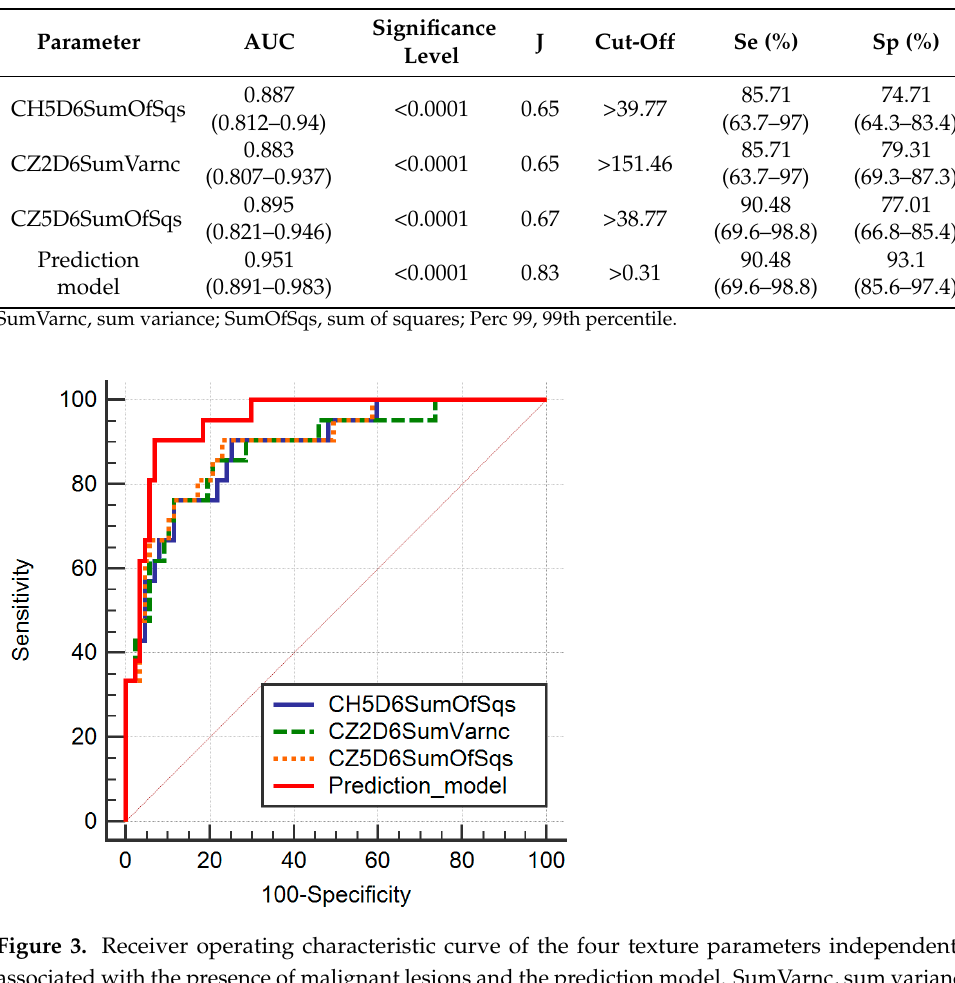
Table 4. The k-nearest neighbor classifier’s results. The values between the brackets corresponding to the 95% confidence interval. KNN, k-nearest neighbor classifier.